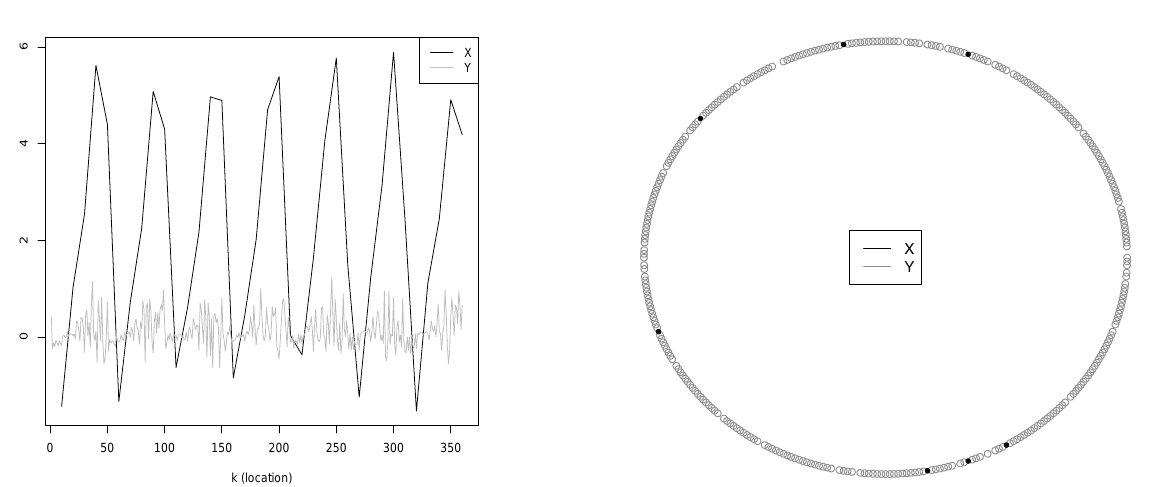
Figure 2. A snapshot of the variables X and Y from a numerical integration of the system of Eqs. (14) and (15) with K = 36, J = 10, F = 10, a = 10, b = 10, and h = 2.